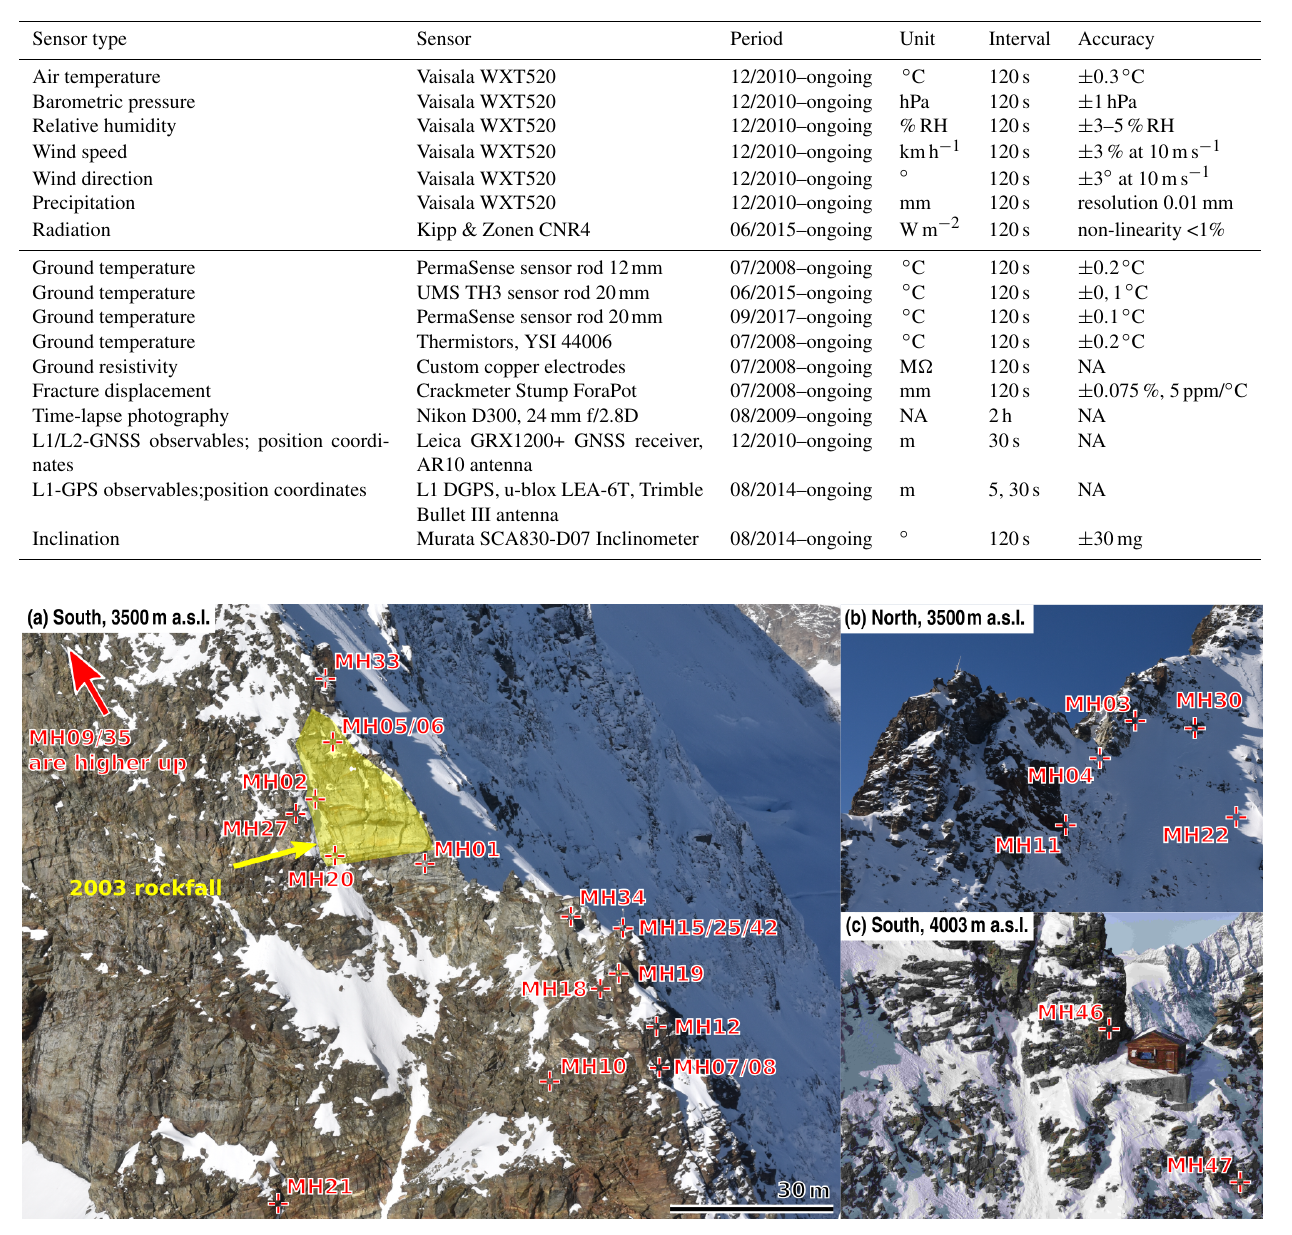
Table 1. Overview list of the sensors used ordered by sensor type. NA – not available.